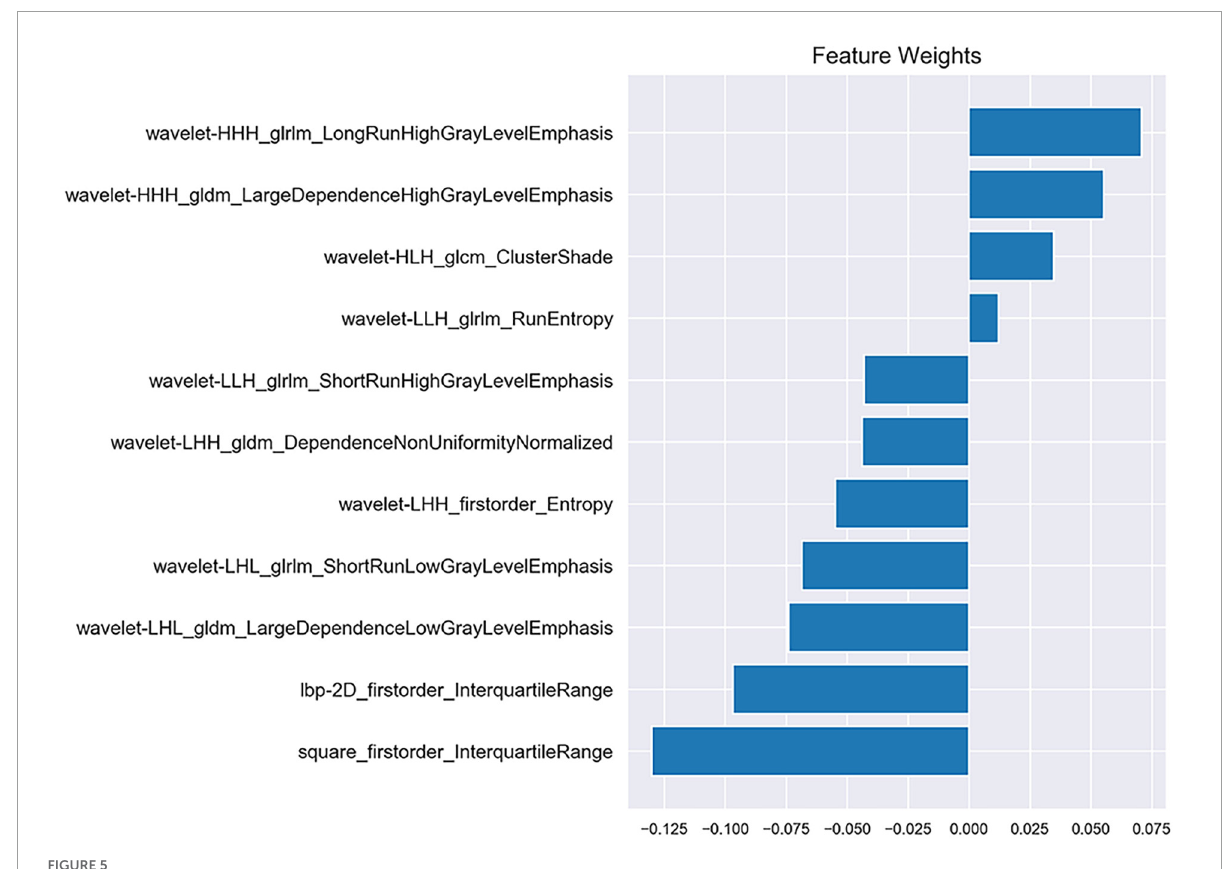
FIGURE5 Information of 11 selected features and corresponding feature weights.